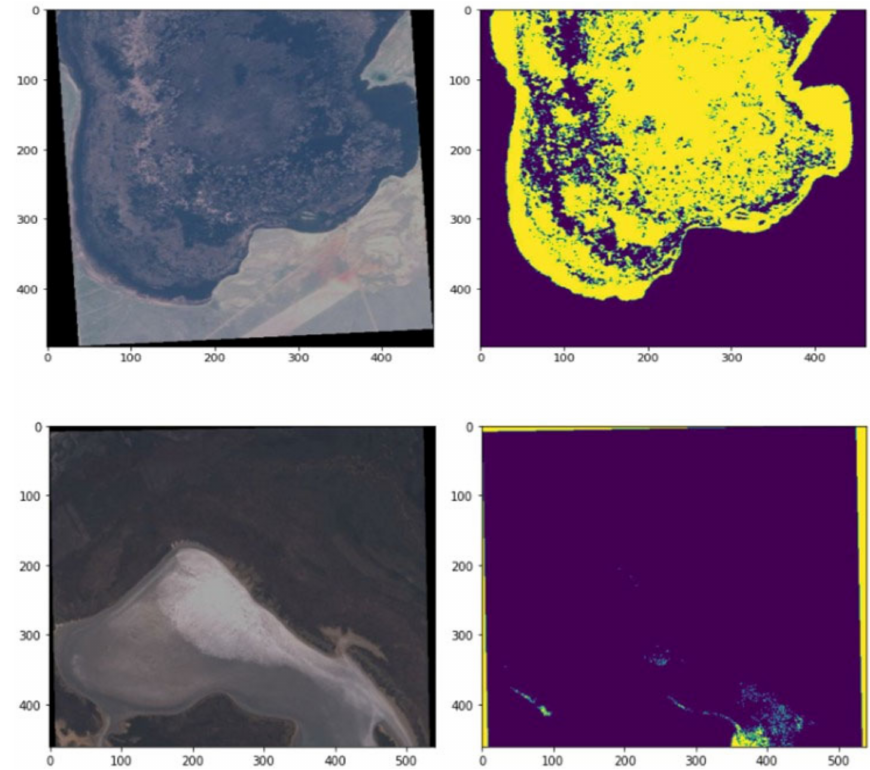
Figure 5. Sample image and corresponding mask.